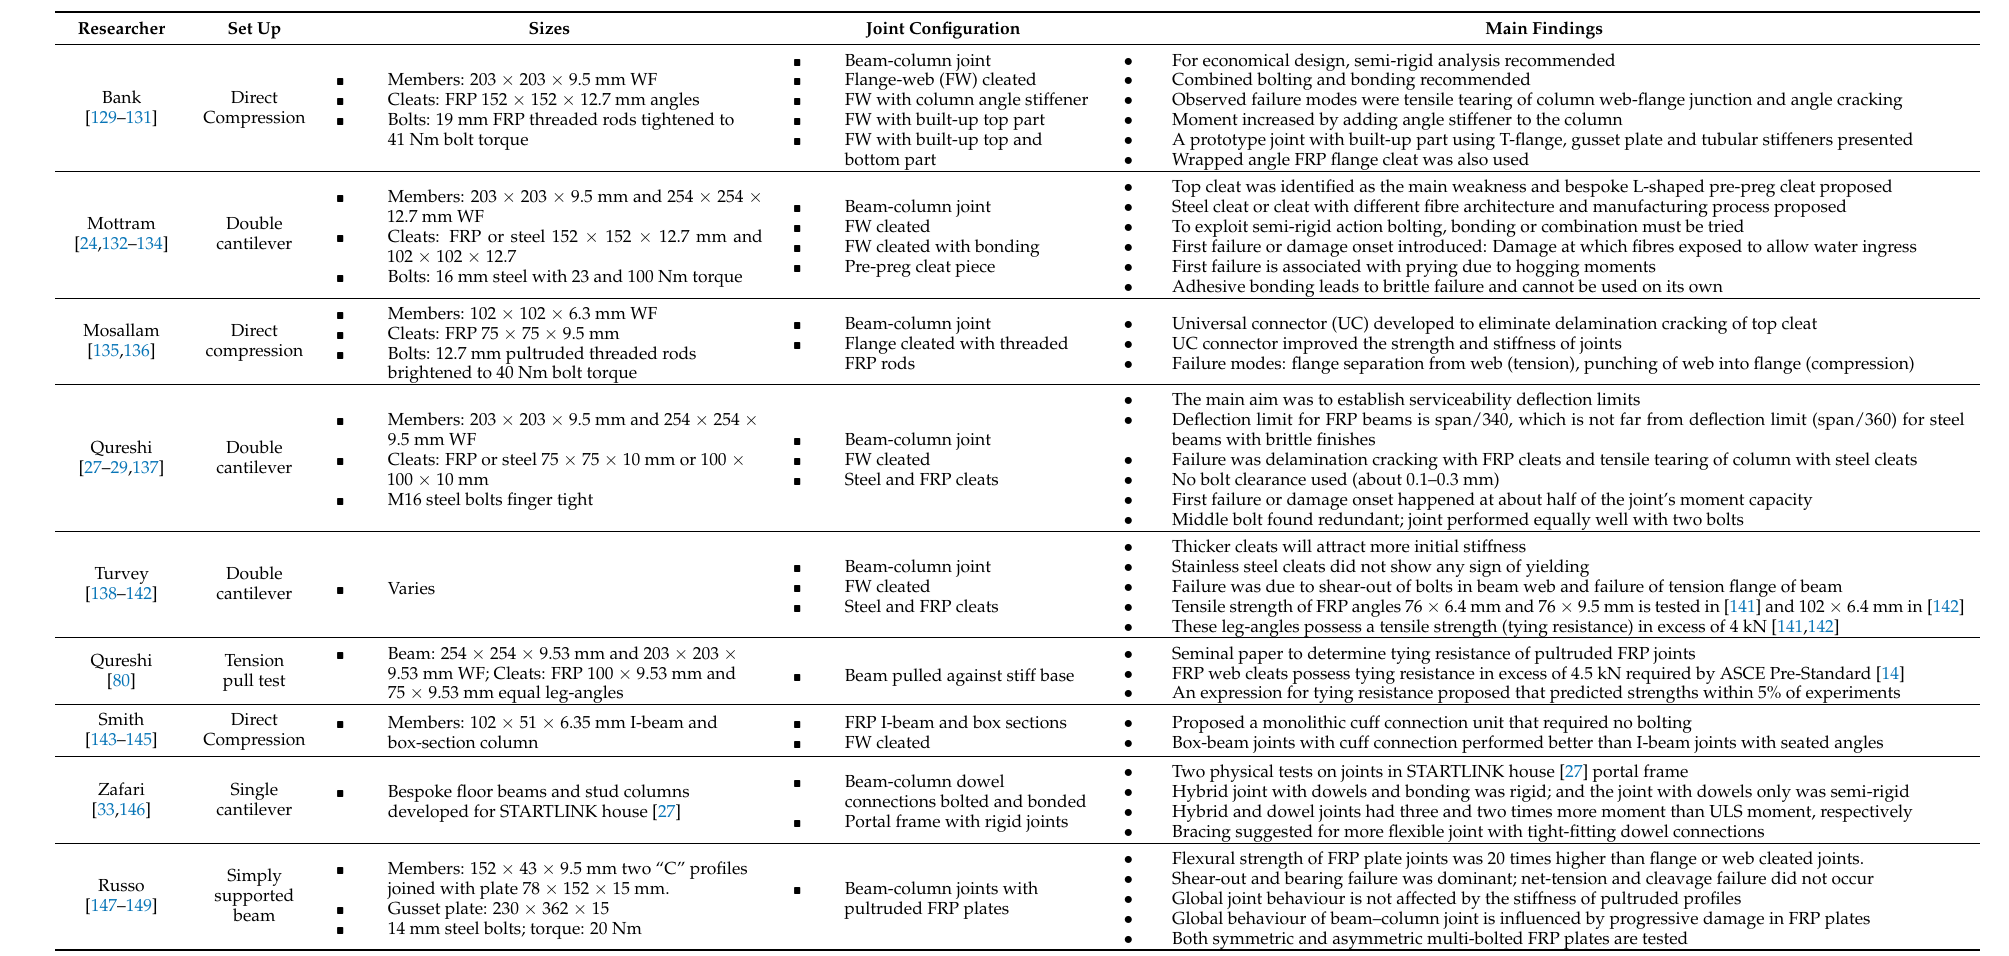
Table 6. Main findings for FRP frame joints subjected to monotonic